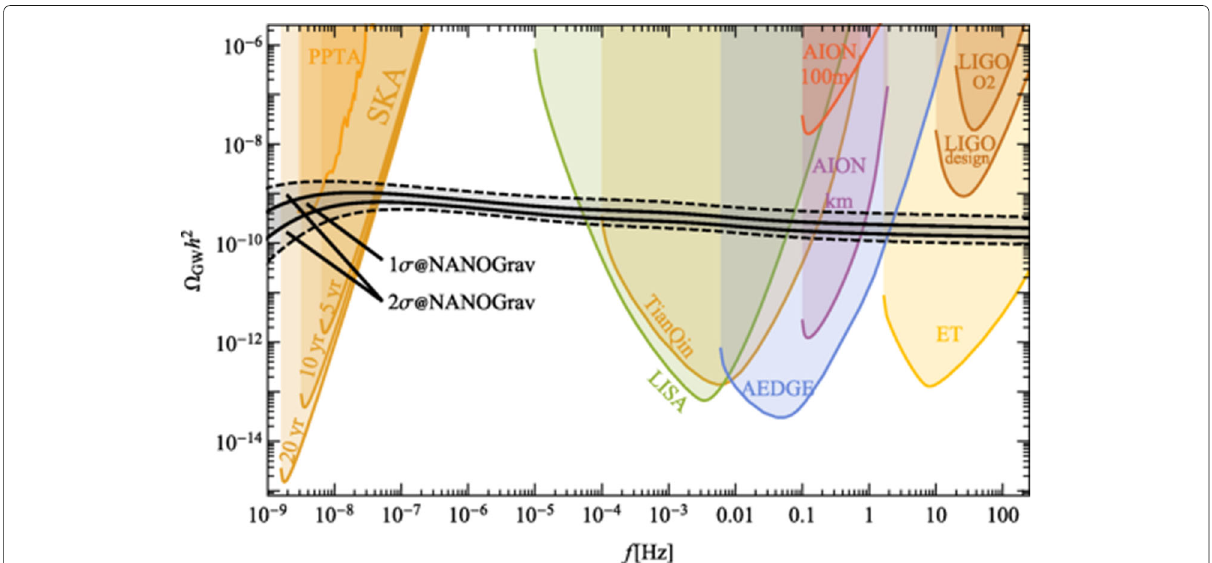
Fig. 7 Spectrum of stochastic gravitational wave back ground generated by cosmic string networks in the scaling regime fitted to the 12.5-year NANOGrav data assuming that their signal entirely comes from strings. Taken from